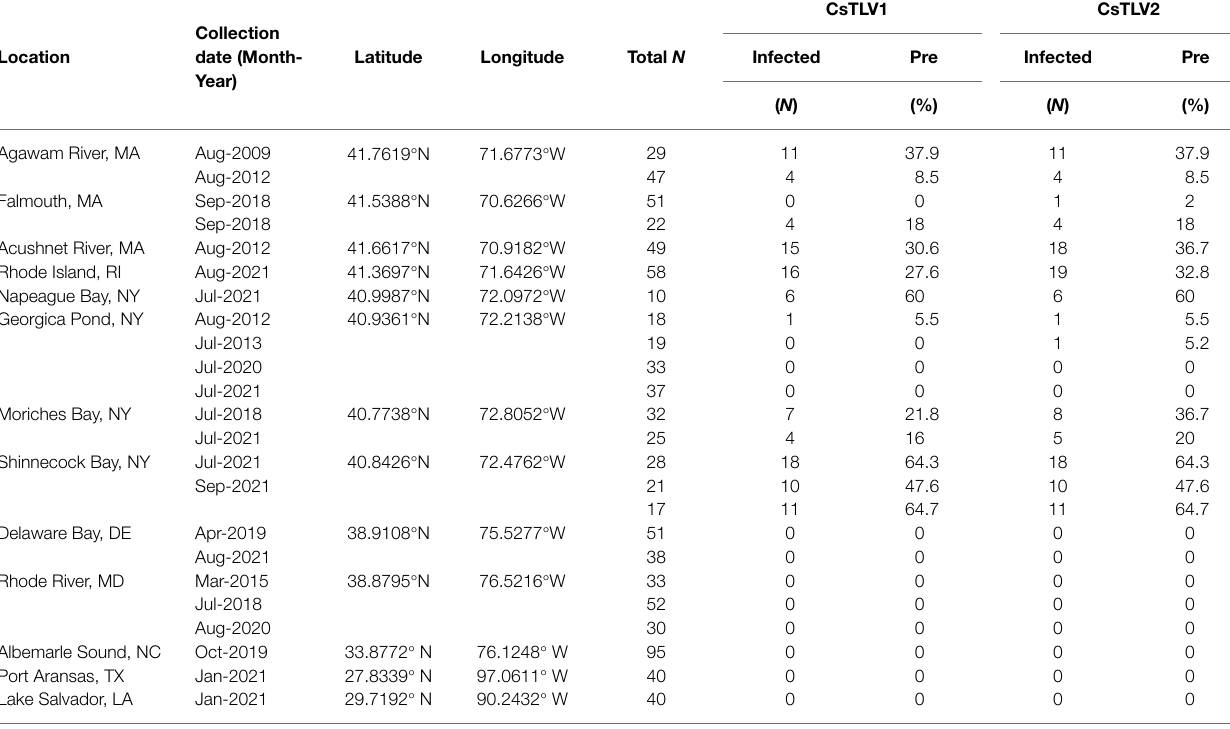
TABLE 3 | CsTLV1 and CsTLV2 prevalence in C. sapidus . Specimens were collected from locations along the US Atlantic coasts and Gulf coasts of the United States.